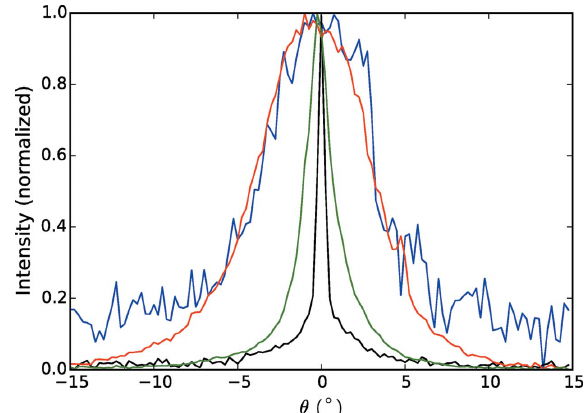
Figure 5 Angular profiles of an equatorial reflection (blue) and the strong reflection on the first layer line (red) in the averaged diffraction pattern shown in Fig. 4( b ). Also shown are the angular profiles of the same equatorial (black) and first layer line (green) reflections after reorienting and averaging the diffraction patterns (Fig. 4 c